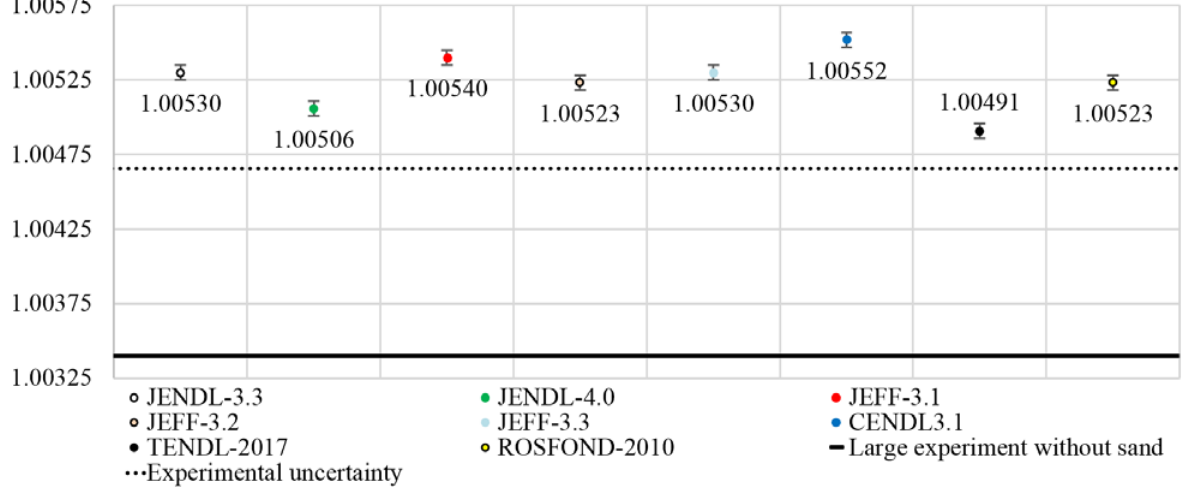
Figure 5. Multiplication factors for large experiment with silicon in other nuclear data